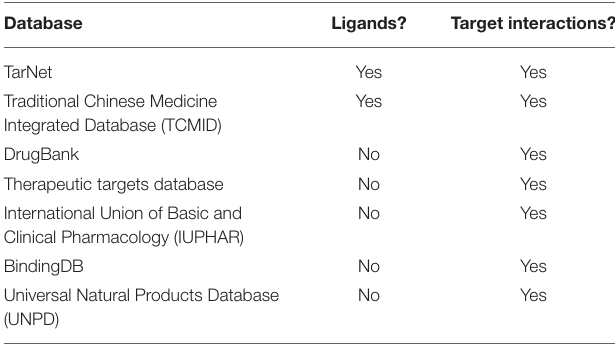
TABLE 1 | Public resources for natural product ligands and associated target